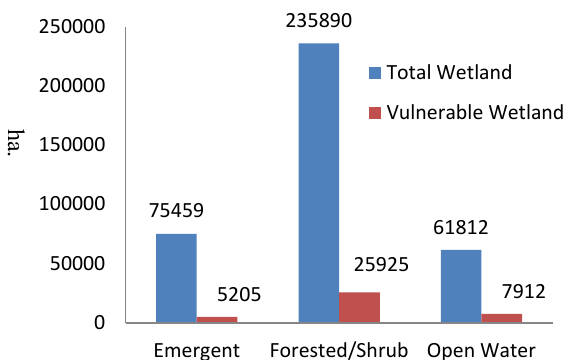
Fig. 6: Total extent of inland wetland types and their respective area potentially vulnerable to urbanization, agricultural expansion and temperature increase by the year 2080 in middle Tennessee, USA